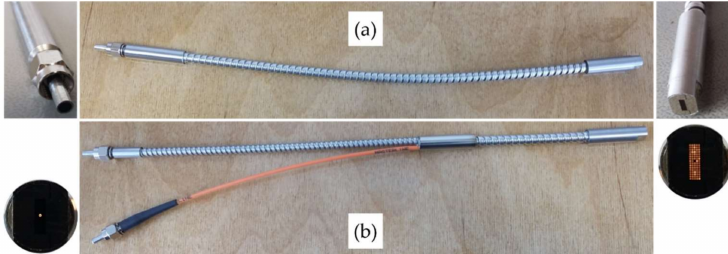
Figure 4. ( a ) Optical fiber coupling of the Xenon flash lamp with the monochromator (labeled (1) in Figure 2b). ( b ) Optical Y-fiber coupling of the monochromator with the reference spectrometer and the water sample flow-through cell (labeled (2) in Figure